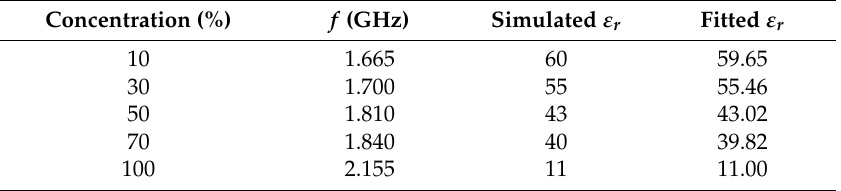
Figure 14. Simulated and measured resonance characteristics of ethanol – water mixtures at ( a ) 10%; ( b ) 30%; ( c ) 50%; ( d ) 70%; ( e ) 100% concentrations. Table 5. Measured resonant frequencies and dielectric constants of ethanol–water mixtures at different concentrations.